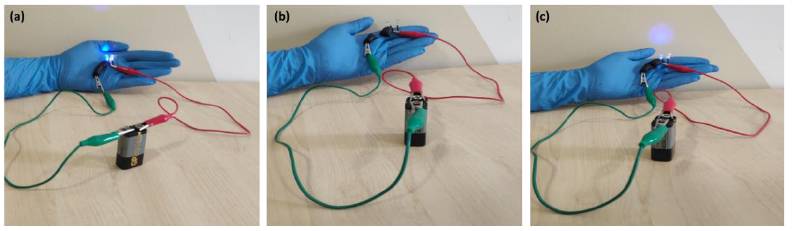
Figure 9. ( a ) I-V curve used for (A/P:P) at concentrations 2.5 and 5 mL of PEDOT:PSS. ( b ) Contact geometry for four-line probe where current I is injected and removed by the two outer contacts, and potential difference ΔV is measured by the two inner contacts.